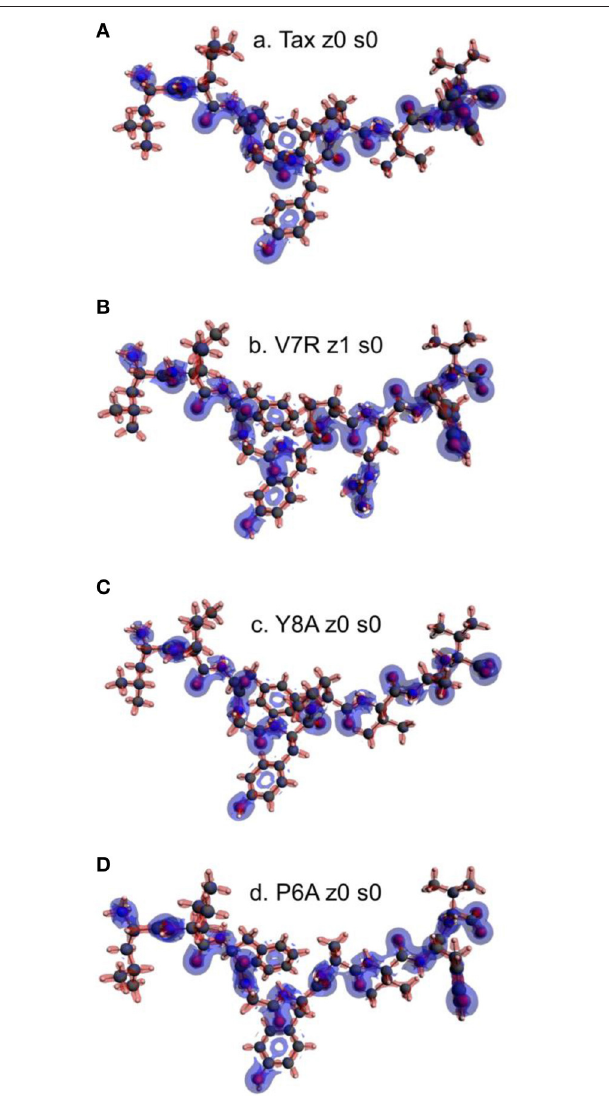
FIGURE 9 | Laplacian of the electron density of non-polarized peptide structures. All triggering side chains are fully protonated. From (A–D) : Tax z0 s0, V7R z1 s0, Y8A z0 s0, and P6A z0 s0. Charge concentration (high potential energy) and charge depletion (high kinetic energy) are shown as red and blue surfaces, respectively. All iso-density surfaces are drawn at 0.2